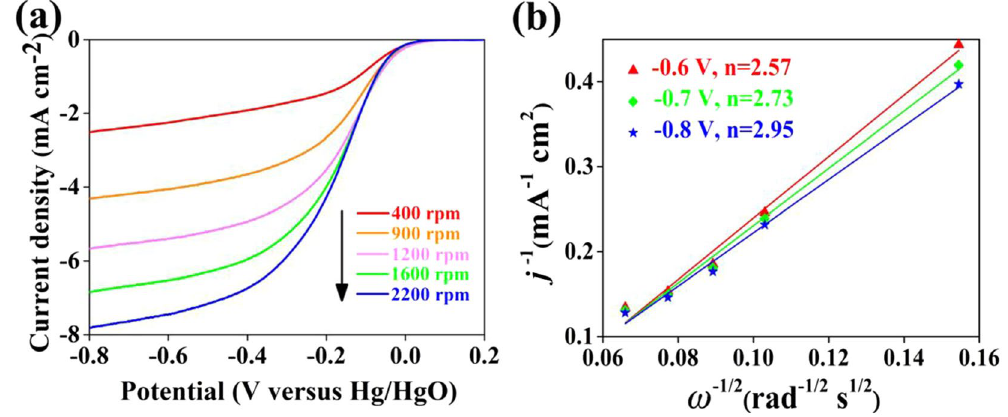
Figure 6. ( a ) ORR polarization curves for Ag/CFP-3 at different rotating rates. ( b ) Koutecky-Levich plots collected from the